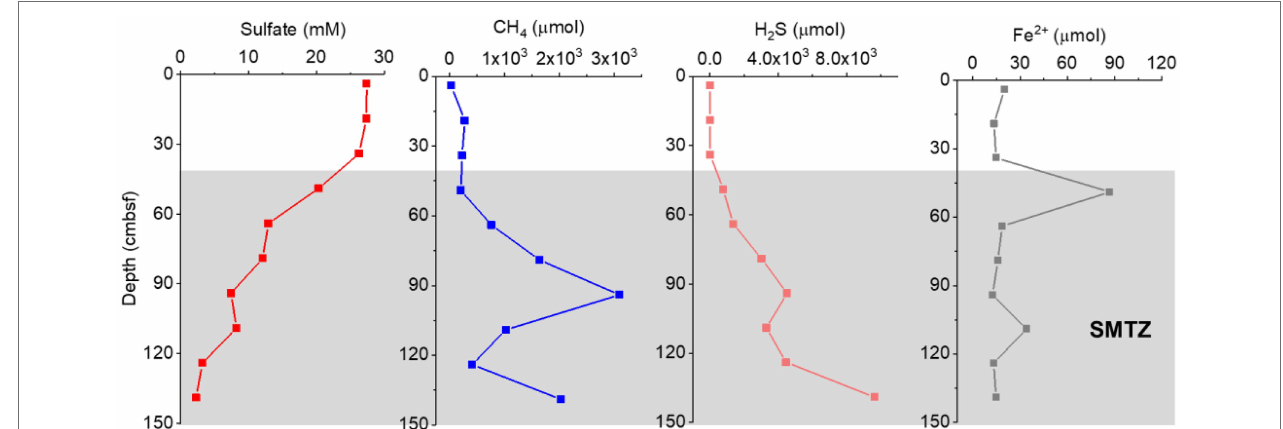
FIGURE 2 | Geochemical profiles for the concentrations of sulfate, CH 4 , H 2 S, and Fe 2+ in the GC2020-02